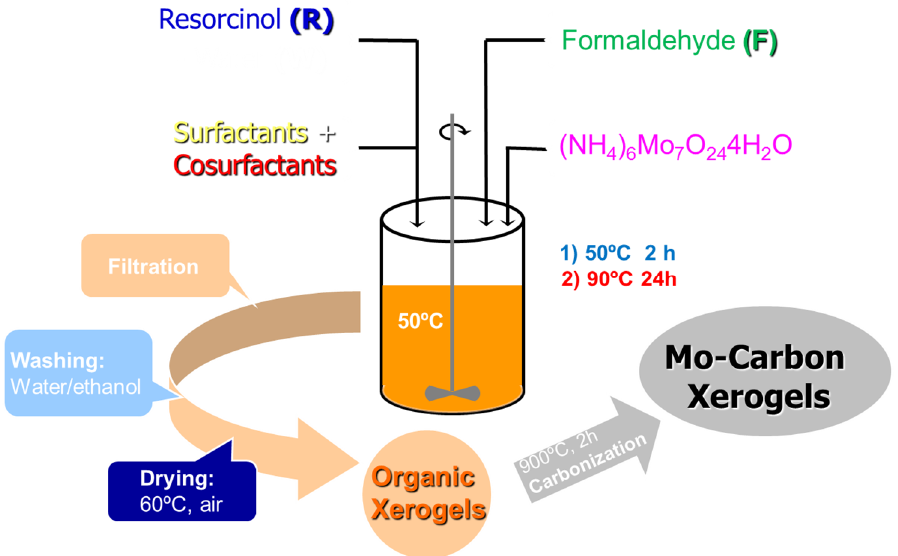
Figure 8. Preparation of metal-doped carbon xerogel powder.